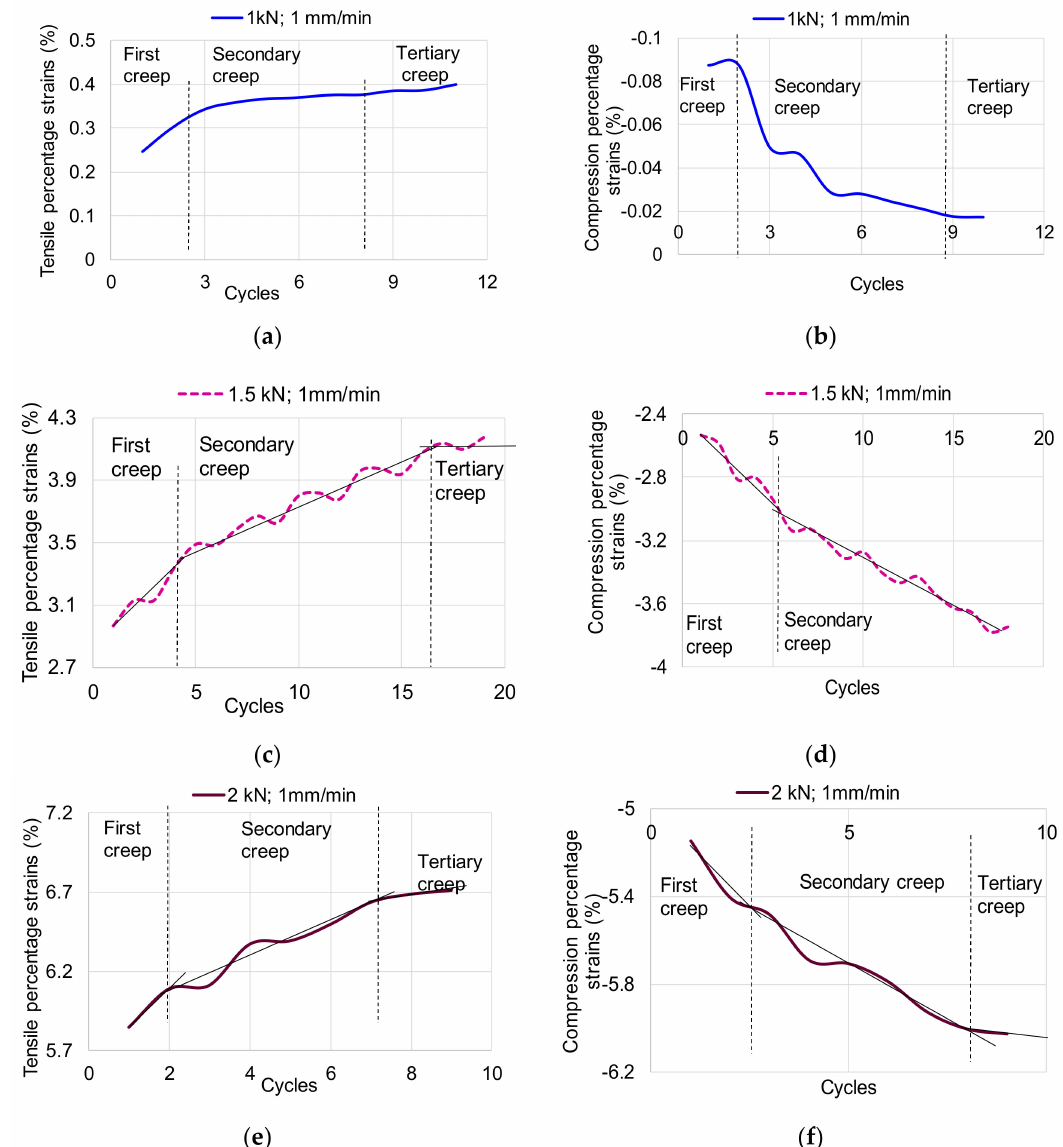
Figure 5. Master curves: ( a ) tensile strains of sample P3 subjected to 1 mm / min and F = ± 1kN; ( b ) compression strains of sample P3 subjected to 1 mm / min and F = ± 1kN; ( c ) tensile strains of sample P6 subjected to 1 mm / min and F = ± 1.5 kN; ( d ) compression strains of sample P6 subjected to 1 mm / min and F = ± 1.5 kN; ( e ) tensile strains of sample P9 subjected to 1 mm / min and F = ± 2kN; ( f ) compression strains of sample P9 subjected to 1 mm / min and F = ±